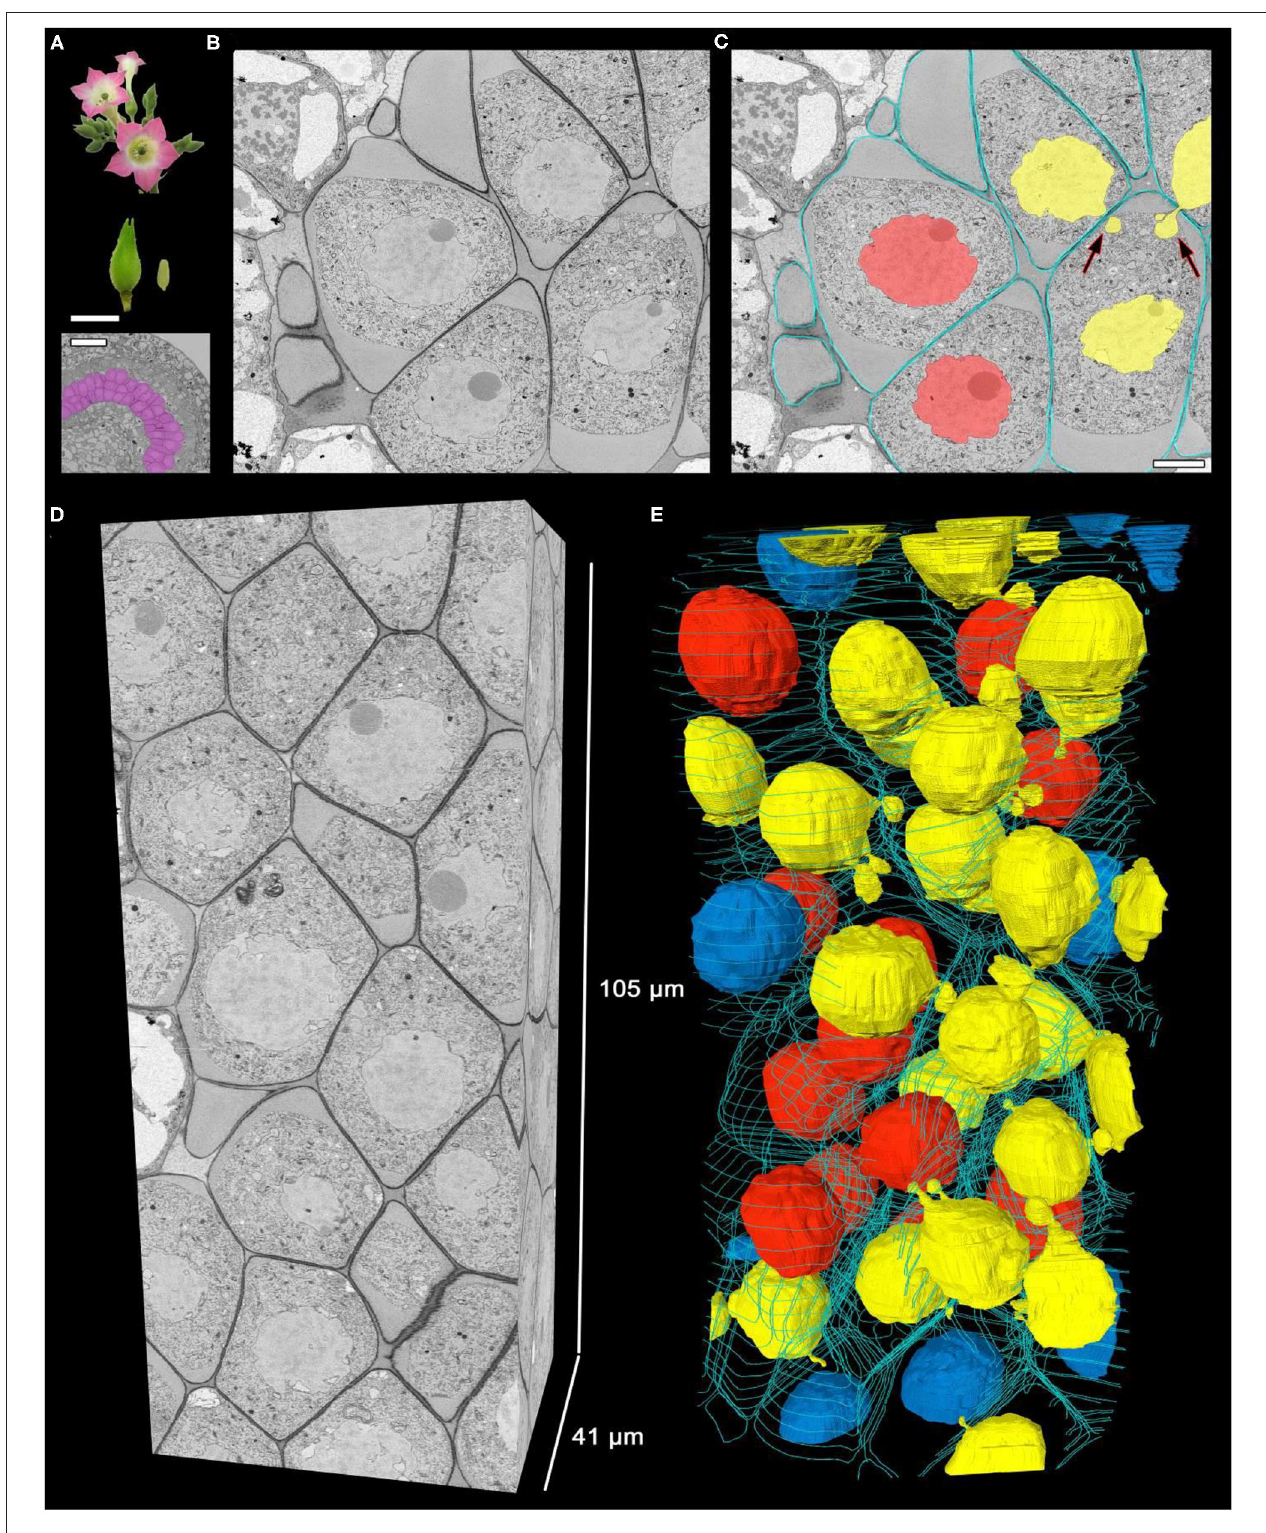
FIGURE 1 | Three-dimensional reconstruction of male meiocytes in a tobacco anther. (A) Tobacco flowers, a flower bud, an anther, and transverse section of an anther locule. The purple color indicates meiocytes. (B,C) A meiocyte micrograph obtained by SBF-SEM at pachytene. An original image (B) and the same image after cell walls and nuclei were labeled (C) . (D,E) Three-dimensional reconstructions of a scanned tissue fragment from 2,626 serial images. The whole unlabeled